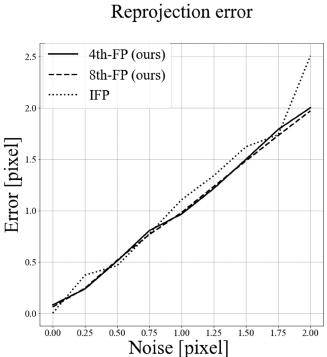
Figure 5: Evaluation of the calibration reprojection error es- timation as a function of increasing Gaussian noise with a 2- D calibration target. All evaluations are done for the pro- posed 4- and 8-degree polynomials and compared to the iter- ative forward-projection solution.